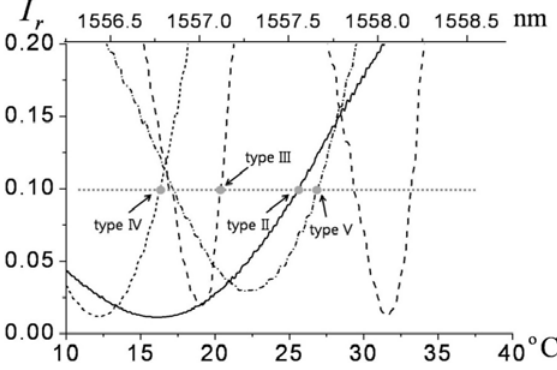
Figure 12. Wavelength bias points (gray dots) for probes II through V in Figure 11 on their respective reflectance fringes. (The biases were set at 10% of the peak